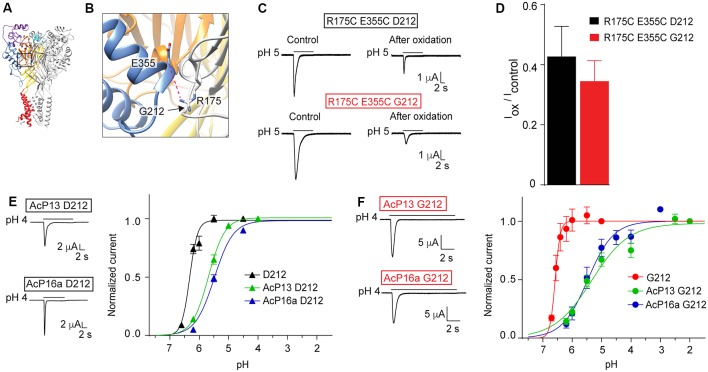
Mutations in and close to the acidic pocket. All experiments of this figure are from hASIC1a expressed in Xenopus oocytes, voltage-clamped to −60 mV. (A,B) Overview and detailed view of a structural model of hASIC1a, based on the crystal structure of cASIC1a (Baconguis et al., 2014), showing the subunit interface between the thumb of one subunit (blue) and the palm domain of an adjacent subunit (gray). The predicted hydrogen bond Arg175 – Glu355 is shown as a pink dashed line. (C) Representative current traces of R175C E355C D212 and R175C E355C G212 mutants before and after the oxidation treatment with copper phenanthroline. The oxidation treatment was done exactly as described (Gwiazda et al., 2015). (D), The IpH5.0 (after oxidation)/IpH5.0 (before oxidation) ratio is shown (n = 5–9; E). Left, representative current traces of mutants AcP13 D212 and AcP16a D212, measured in response to an acidification to pH 4.0 from a conditioning pH of 8.0 and 7.6, respectively. Right, pH dependence of activation of hASIC1a-D212, and the two mutants AcP13 and AcP16a in the hASIC1a-D212 background, (n = 2–12). (F) Same as in (E), however in the G212 background, n = 5–6. (E,F) The mutants AcP13 and AcP16a contain the following mutations: AcP13: E97Q/E177Q/D183N/D237N/E238Q/D303N/E315Q/E321Q/H329N/E344Q/D347N/D351N/E355Q; AcP16a: E97Q/E113Q/E177Q/D183N/E235Q/D237N/E238Q/D303N/E315Q/E321Q/H329N/E340Q/E344Q/D347N/D351N/E355Q. The conditioning pH was 7.4, except for AcP13, where it was 8.0, and AcP16a (pH 7.6).